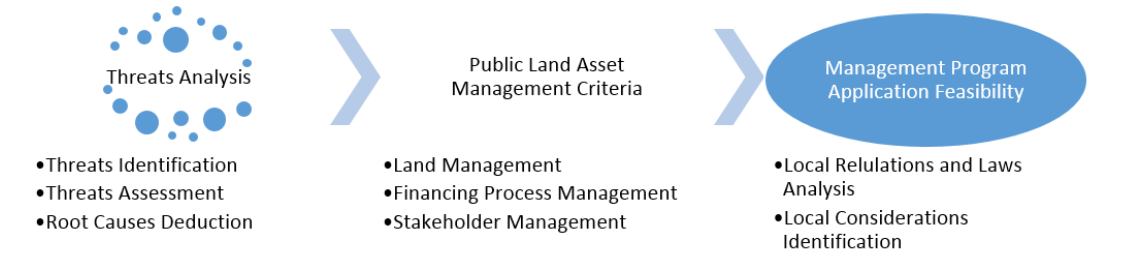
Figure 3. Public Land Asset Management Framework Parts -Source: